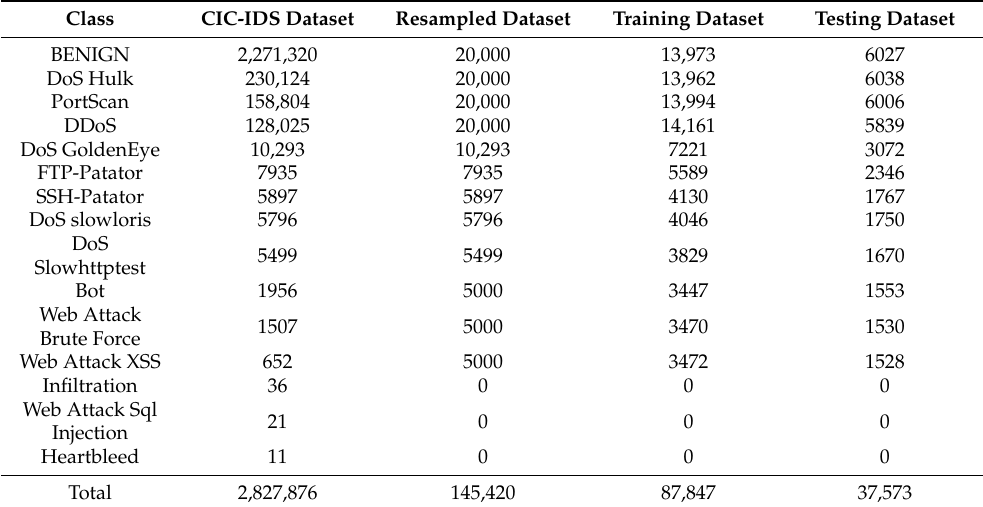
Table 2. CIC-IDS dataset, resampled dataset, training dataset and test